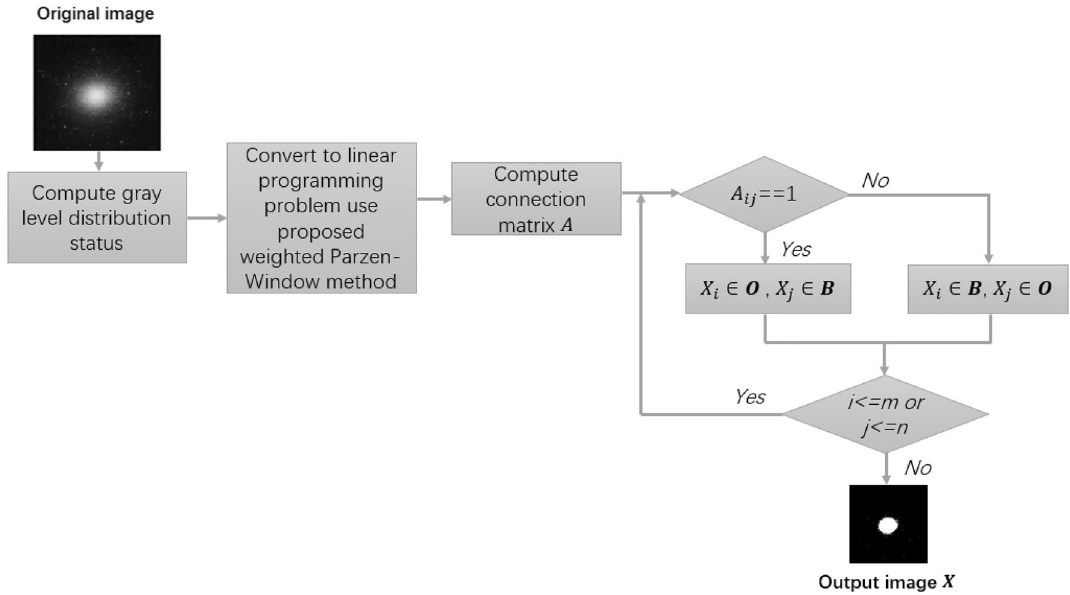
Figure 1. Process of the proposed thresholding